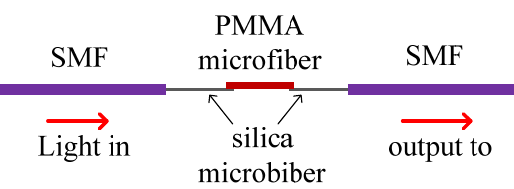
Figure 23. The sensor based on the PMMA microfiber [104].